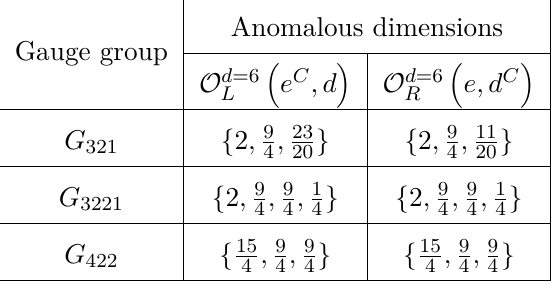
Table 6 . Relevant anomalous dimensions for the considered breaking